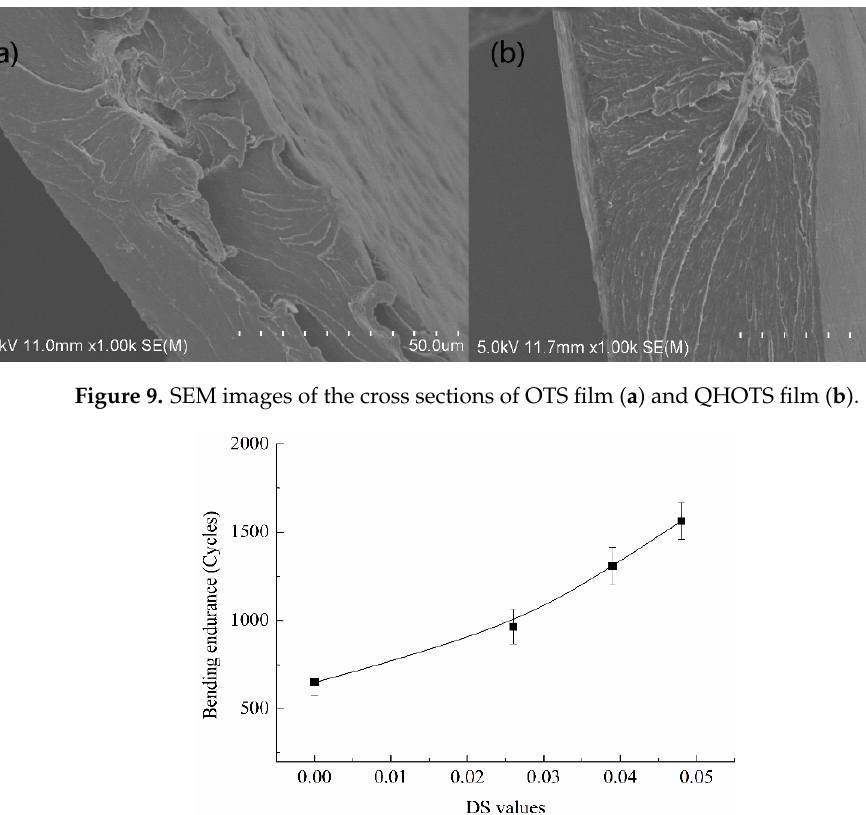
Figure 10. Influence of quaternization/hydroxypropylsulfonation on bending endurance of OTS films.